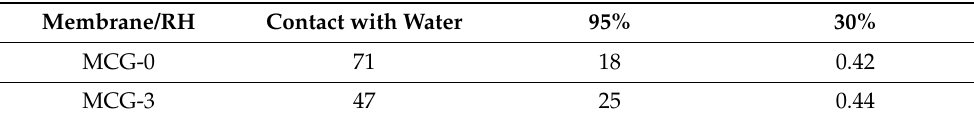
Table 3. Proton conductivity of the obtained membranes (mS/cm) at 30 ◦ C and the different relative humidity. Membrane/RH Contact with Water 95% 30% MCG-0 71 18 0.42 MCG-3 47 25